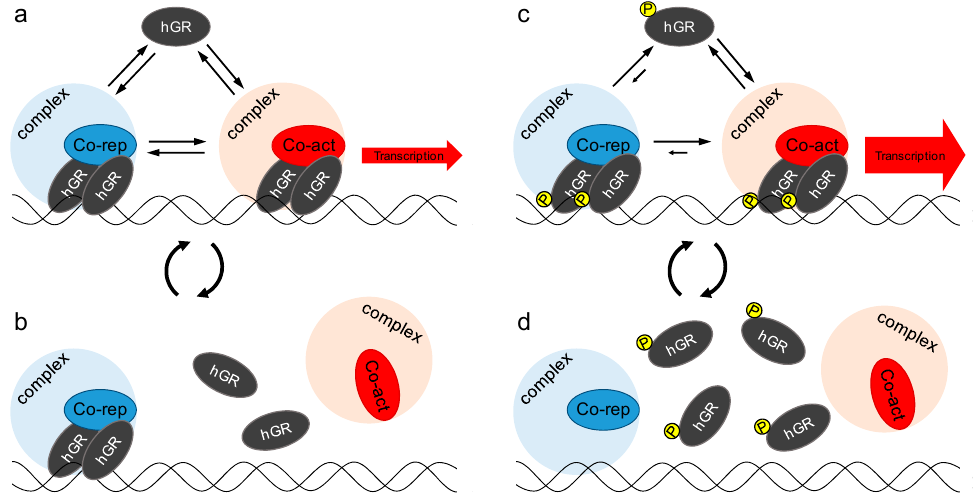
Figure 6. The model of effect of hyper-phosphorylation on transcriptional activity and mobility of hGR. Transcriptional activation is initiated by binding hGR to GBR but controlled by association with the coactivator and corepressor complex. The observed diffusion coefficient was reflected in the total states of hGR. ( a , b ) Restricting the mobility of hGR by association with the corepressor complex resulted in a lower diffusion coefficient; ( c , d ) hyper-phosphorylation of hGR reduced association with the corepressor complex; thus, the transcriptional activity and diffusion coefficient were increased. Co-rep (blue) and Co-act (red) represent the corepressors (such as NCoR) and coactivators (such as GRIP1), respectively. The light blue and red circles are the complex of corepressor and coactivator, respectively. The hGR with a “P” in yellow circle on it represents hyper-phosphorylation.